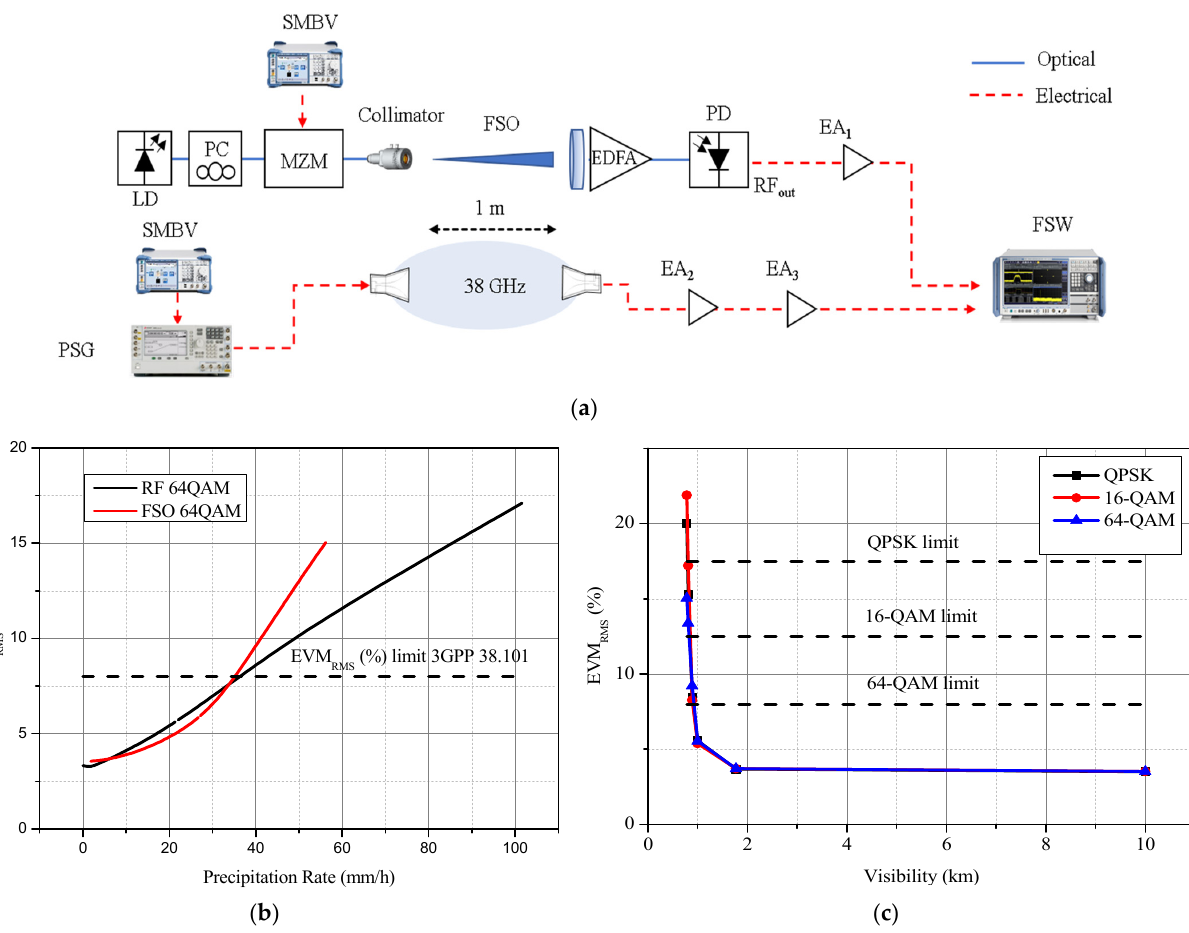
Figure 2. The 5G NR dual wireless and FSO-based fronthaul. ( a ) Block diagram of the proposed hybrid wireless-FSO system. From the left, the signal generated by the vector signal generator (VSG) SMVB100A reaches the FSW signal and spectrum analyzer via the two different links. ( b ) Dependence of hybrid FSO/RF EVM RMS as a function of rain precipitation rate. ( c ) Dependence of hybrid FSO/RF EVM RMS as a function of